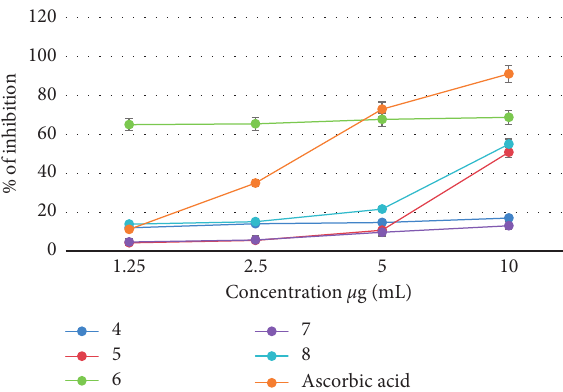
Figure 2: The percentage inhibition of free radical DPPH by the synthesized compounds. Figure 1: The inhibition zone of the synthetic compounds in mm (mean ± SD) at 200 μ g/mL. Results are mean ± SD of duplicate experiments. Amoxicillin was used as positive control; C compounds. Table 2: Percentage inhibition and IC 50 of synthesized compounds and ascorbic acid. Conc.